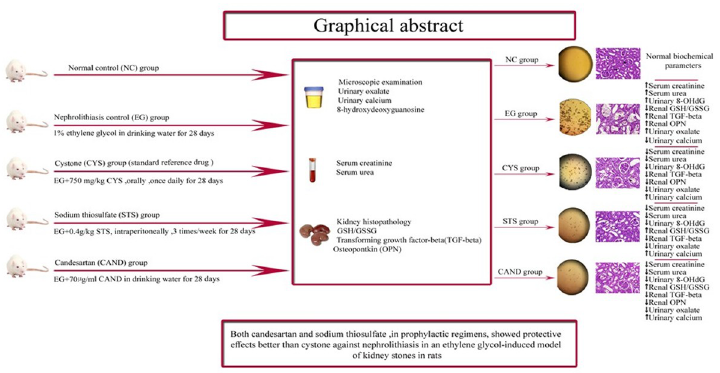
Fig 5. Graphical abstract. NC: Normal control; EG: Ethylene glycol; CYS: Cystone; STS: Sodium thiosulfate; CAND: Candesartan.